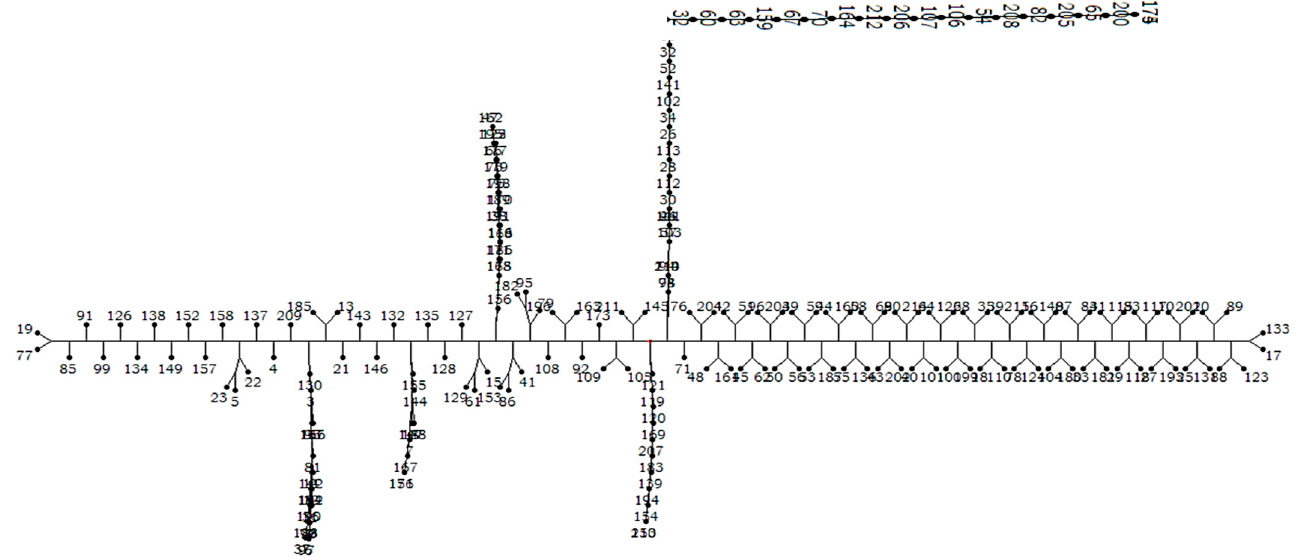
Figure 2. Neighbor-joining tree for evaluated genotypes based on four targeted QTLs. The likelihood ratio chi-square showed a significant association between qDTY2.2 and all the phenotypic data under drought stress. The QTL qDTY1.1 was only signifi- cantly associated with the yield best linear unbiased predictions under drought stress. Other QTLs were not significantly associated with the phenotypic data (Table 4). Table 4. Chi-Square test of independence for phenotypic and genotypic data. Variable d.f. 1